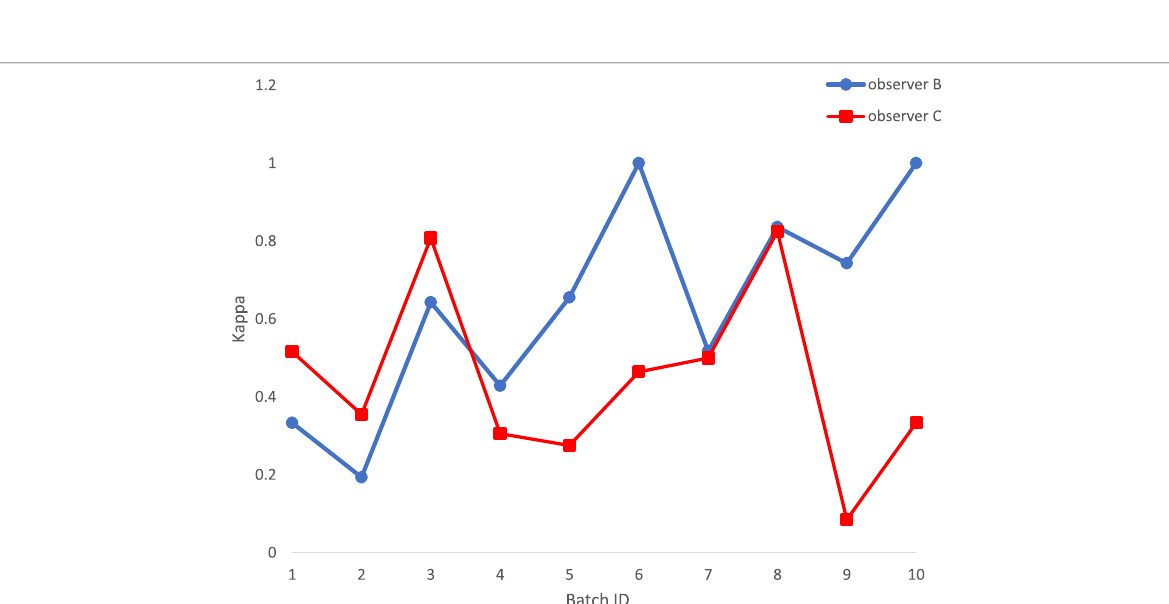
Fig. 3 Kappa values for the variation between the novice observers and the experienced observer on the tongue base level after each cluster of 10 examinations